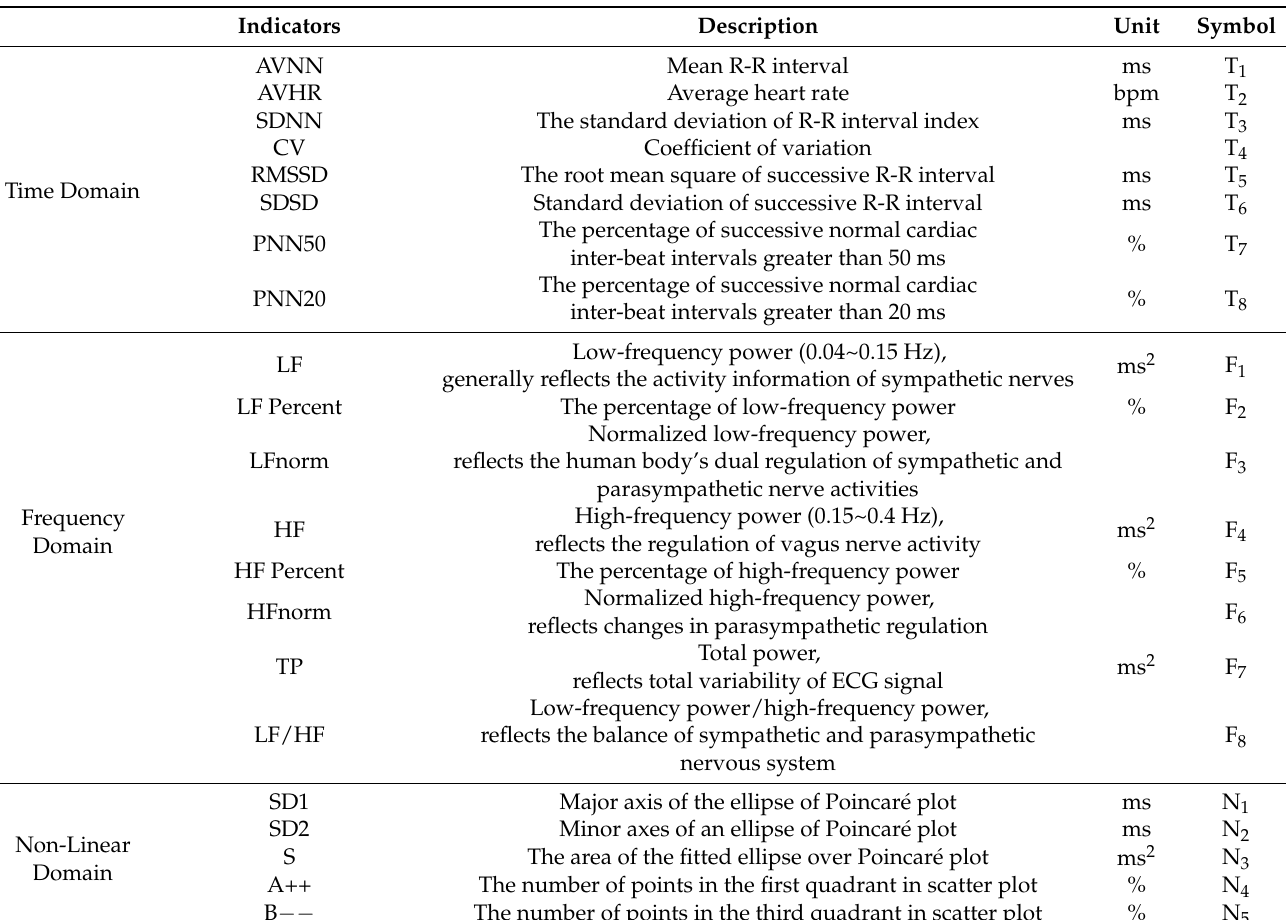
Table 2. Time domain, frequency domain and non-linear indexes.